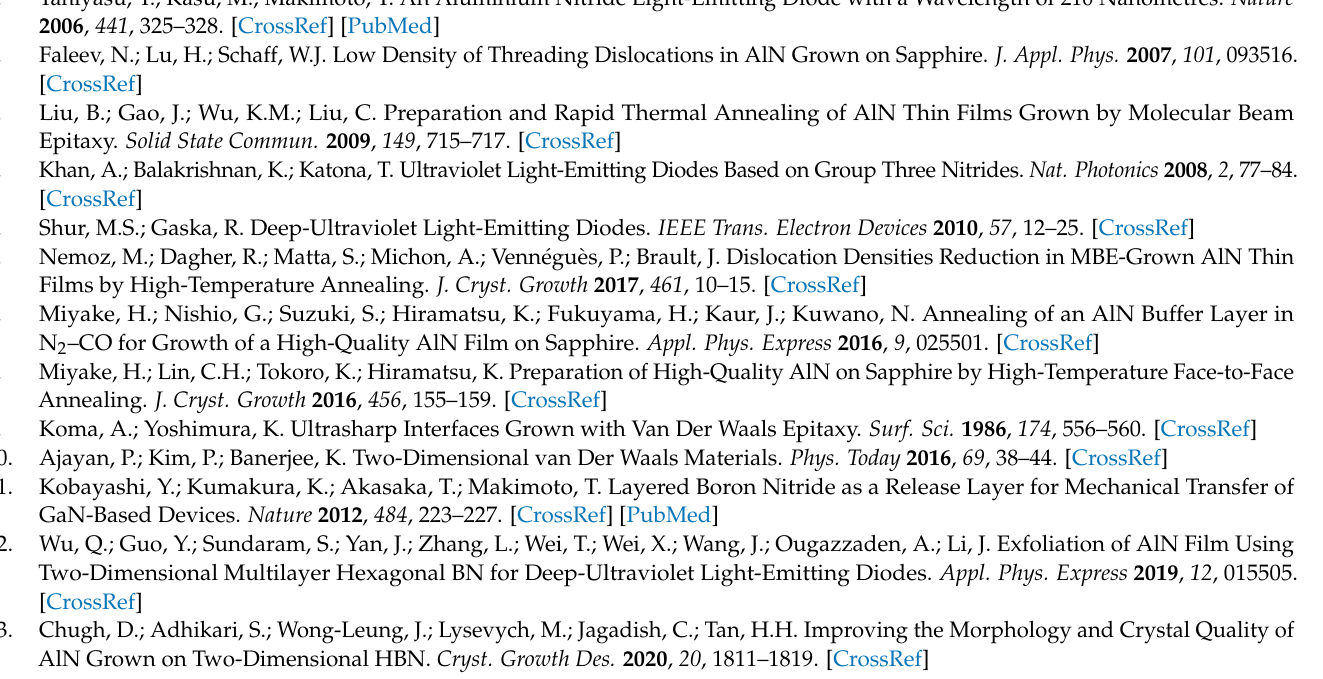
Figure S2: ω -scan of AlN (sample B) before and after FFA: (a) for the symmetric plane (0 0 0 2), (b) for the skew symmetric plane (1 0 − 1 1); Figure S3: ω -scan of AlN (sample C) after regrowth: (a) for the symmetric plane (0 0 0 2), (b) for the skew symmetric plane (1 0 − 1